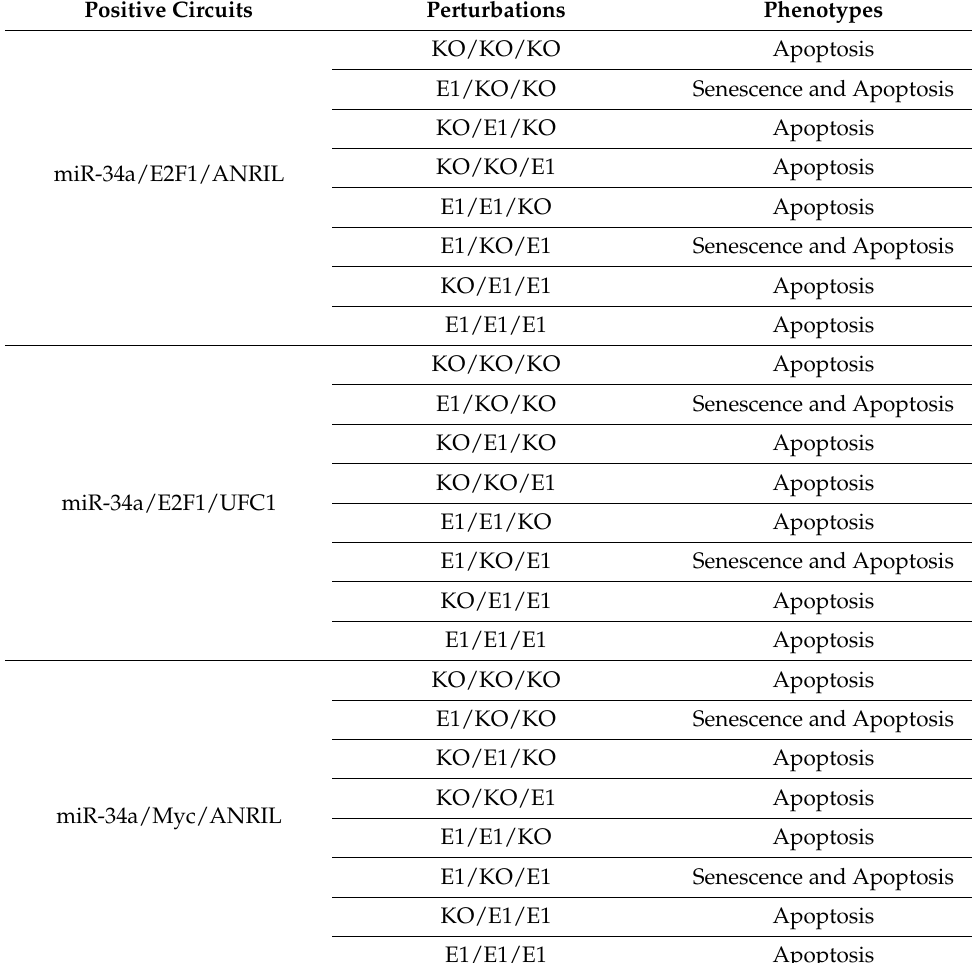
Table 4. Perturbations of the three newly identified positive circuits. Ectopic expression (E1) represents gain-of-function (GoF), whereas, knockdown (KO) represents loss-of-function (LoF),